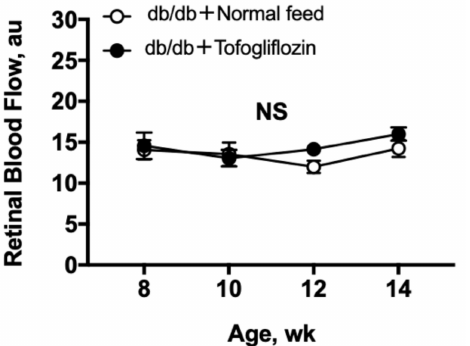
Figure 2. Longitudinal resting RBF remains stable throughout the measurement period from 8 to 14 weeks of age in db/db mice and were not different for db/db mice treated with tofogliflozin ( n = 6) and db/db mice fed normal chow ( n = 6) from 8 to 14 weeks of age. RBF was measured every 2 weeks, and the statistical analyses of the results of each treatment over time were performed by a one-way repeated measures ANOVA ( p = 0.32 for db/db + normal feed mice and p = 0.34 for db/db + tofogliflozin mice). The differences between 2 weeks in the resting RBF were tested in the 2 groups by a two-way repeated-measures ANOVA ( p = 0.24). au indicates arbitrary unit; NS indicates no significant difference between groups and within a group. Data are expressed as the mean ±